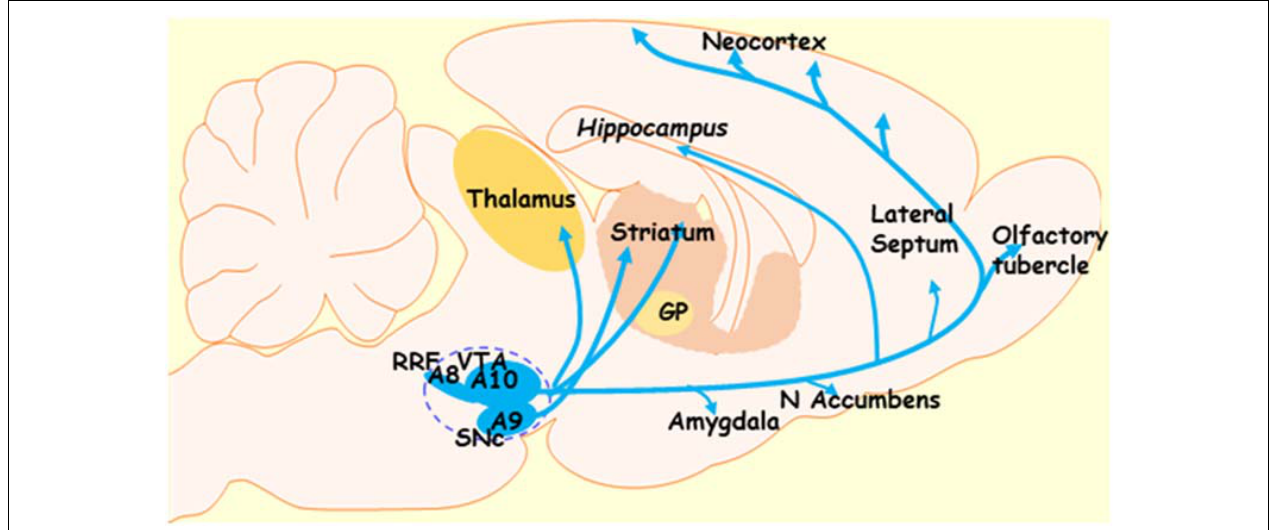
FIGURE 1 | Diagram depicting the dopaminergic system of the midbrain. The dotted lines indicate the dopaminergic regions of the midbrain. GP, globus pallidus; SNc, substantia nigra pars compacta; VTA, ventral tegmental area; RRF, retrorubral field; A8, A9, and A10—clusters of dopaminergic neurons in the midbrain (RRF, SNc, and VTA clusters,